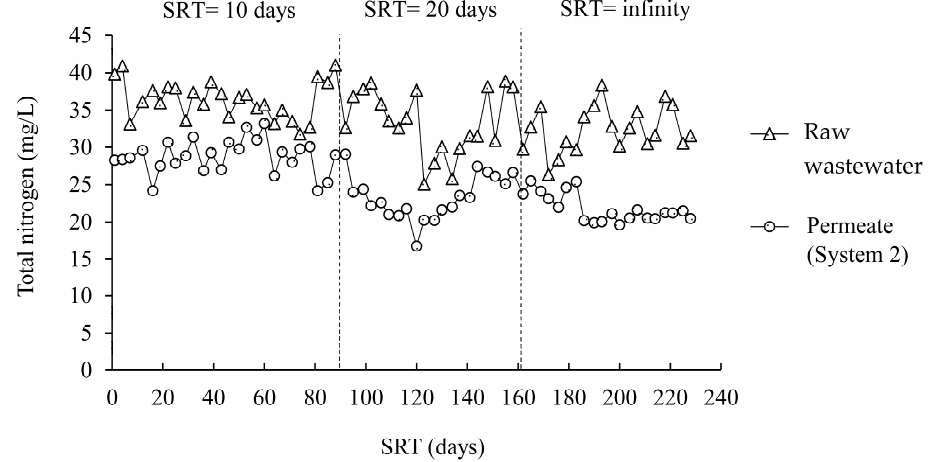
Figure 7. Total nitrogen concentrations during the experiment at different SRTs in the O-MBR system (System 2). Table 3. Efficiencies of the A/O-MBR and O-MBR systems on total nitrogen removal.